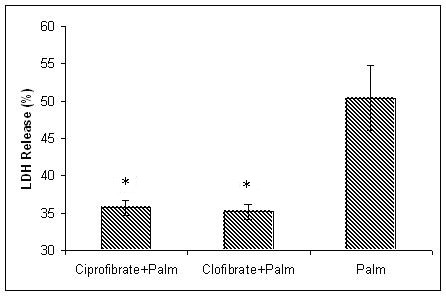
Effect of SCD activators clofibrate and ciprofibrate on LDH release in the palmitate cultures. Clofibrate and ciprofibrate are known to transcriptionally increase the activity of SCD. Palm: treated with 0.7 mM palmitate for 48 hours, Palm+clofibrate: treated with 50 μM clofibrate and 0.7 mM palmitate, Palm+ciprofibrate: treated with 50 μM ciprofibrate and 0.7 mM palmitate. 6 hours pretreatment followed by 48 hours co-supplementation of 50 μM of clofibrate or ciprofibrate significantly decrease LDH release in the palmitate culture, P < 0.01 (t-test). Data expressed as average +/- SD from three independent experiments, * significantly lower than in control, p < 0.01 by t-test. H: control, P: palmitate treatment, O: oleate treatment, P+O: palmitate and oleate co-supplementation.